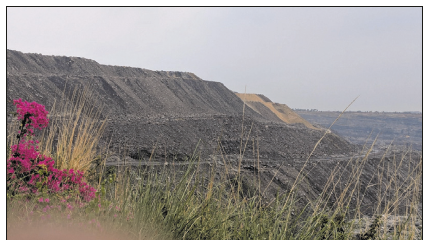
Figure 2: In-pit mining waste dump at the study